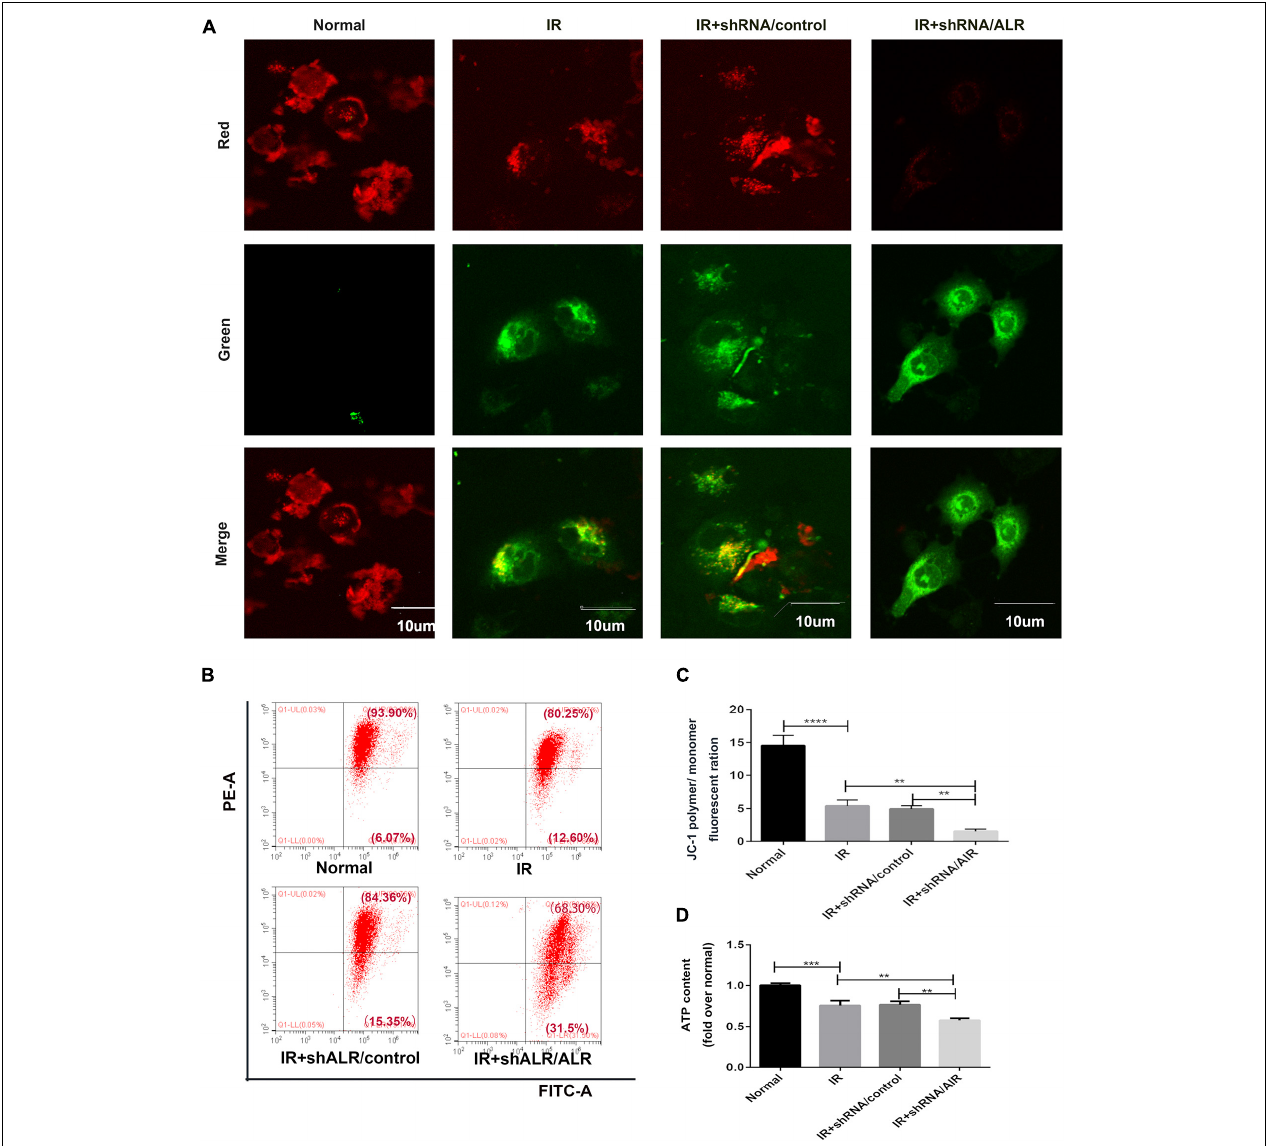
FIGURE 6 | Silencing of augmenter of liver regeneration (ALR) aggravated ischemia–reperfusion (I/R)-induced mitochondrial dysfunction in HK-2 cells. (A) Representative fluorescence images of HK-2 cells stained by JC-1. The picture was detected by confocal laser scanning microscopy (CLSM). Scale bar = 10 µ m. (B,C) Representative images and analysis of mitochondrial membrane potential (MMP) via flow cytometry. (D) ATP contents. Using an ATP assay kit to measure ATP levels for each group. Data represent as the means ± SD. n = 3. ** p < 0.01, *** p < 0.001, **** p < 0.0001.